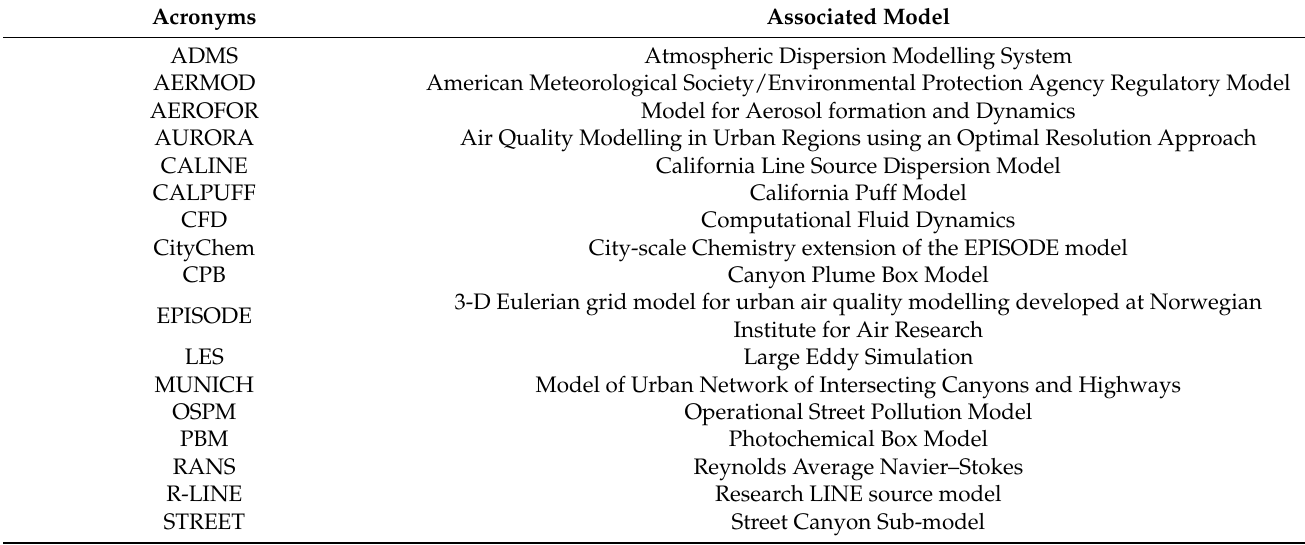
Table 1. Acronyms of